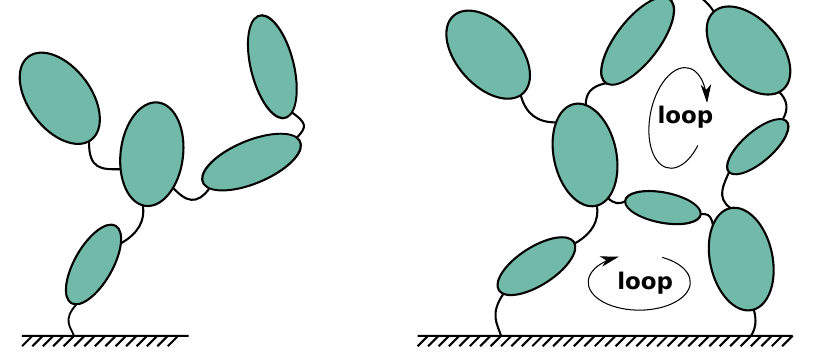
Figure 2. Tree-like ( left ) and closed-loop ( right ) MBS topologies. Tree-Like MBS